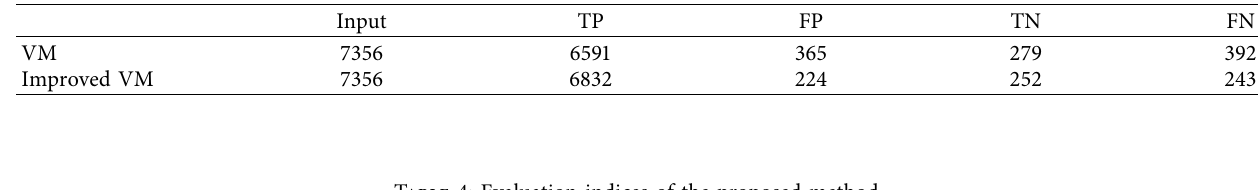
Table 3: Comparison of the detection effect of VM and improved VM in an environment with reflection.